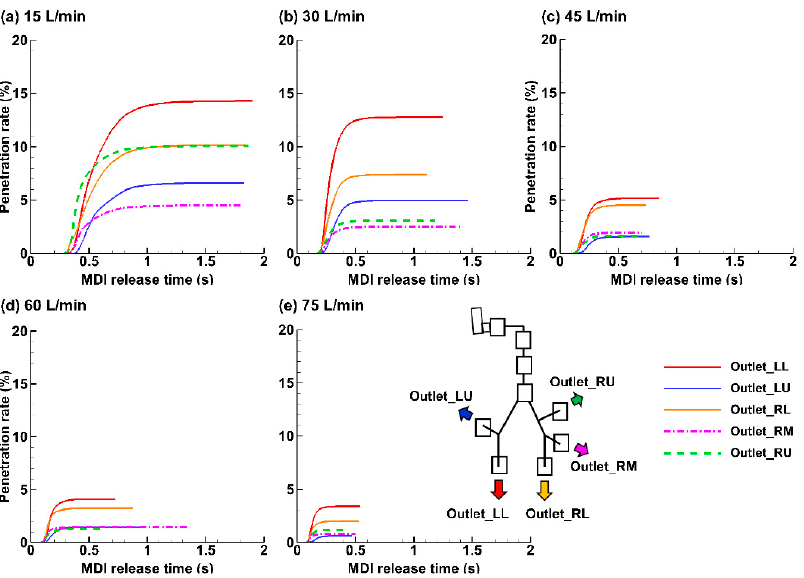
Figure 12. Temporal evolution of the penetration rate into peripheral lungs under varying breathing depths (Q max ): ( a ) 15 L/min, ( b ) 30 L/min, ( c ) 45 L/min, ( d ) 60 L/min, and ( e ) 75 L/min.